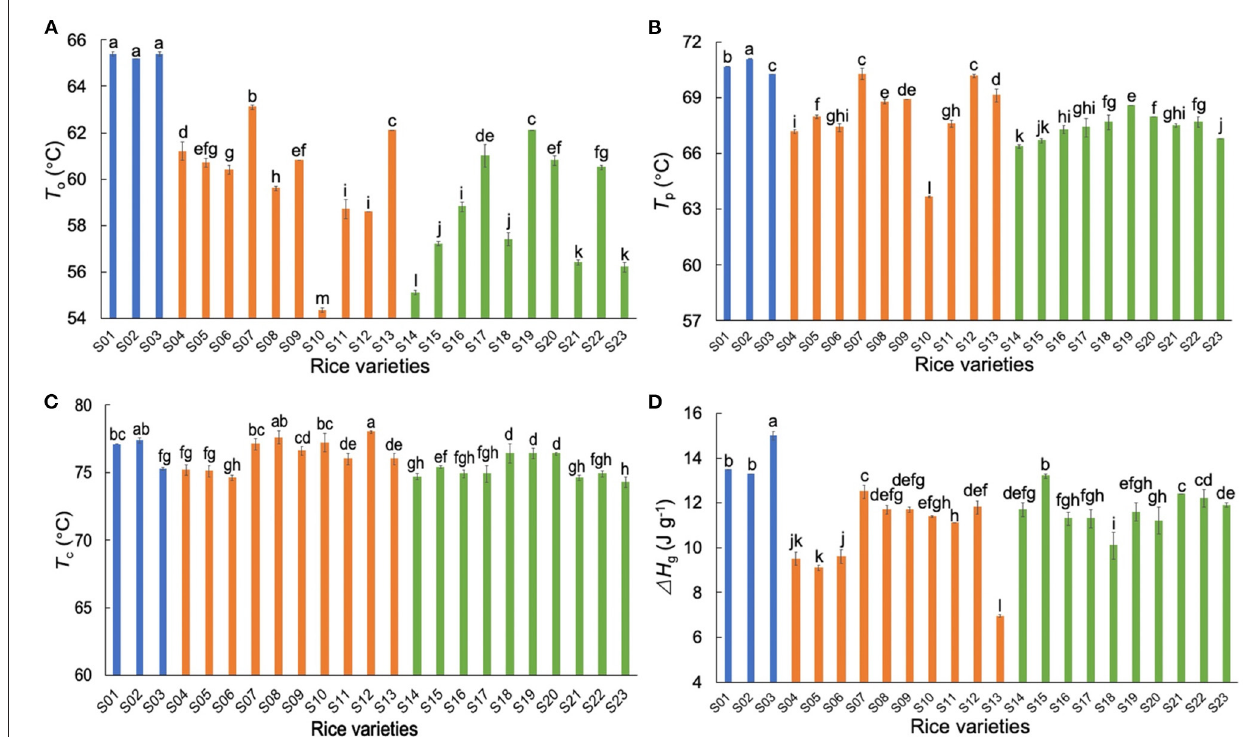
FIGURE 2 | Comparison of thermal properties of native Australian Wild Rice (AWR) and Domesticated Rice (DR) starches. (A–D) The onset temperature ( T o ), the peak temperature ( T p ), the conclusion temperature ( T c ), and the crystal melting enthalpy ( 1 H g ), respectively. Blue, orange and green: Australian wild (S01–S03), indica (S04–S13), and japonica rices (S14–S23), respectively. All data were from triplicate measurements. The same letters mean no significant difference ( p <